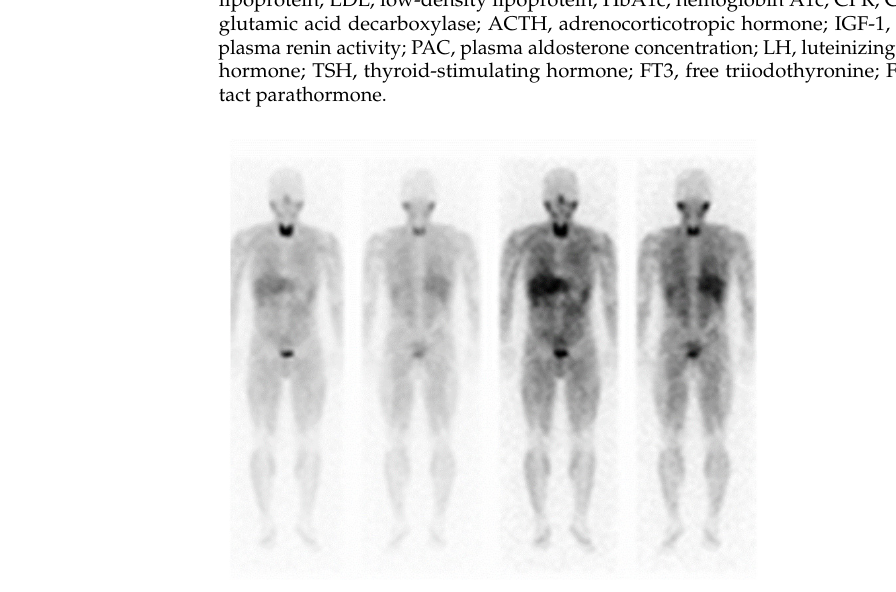
Figure 2. 123 I-metaiodobenzylguanidine (MIBG) scintigraphy of the patient from the present case. Functional imaging of the patient with MIBG-negative pheochromocytoma. The left adrenal tumor was not detected.